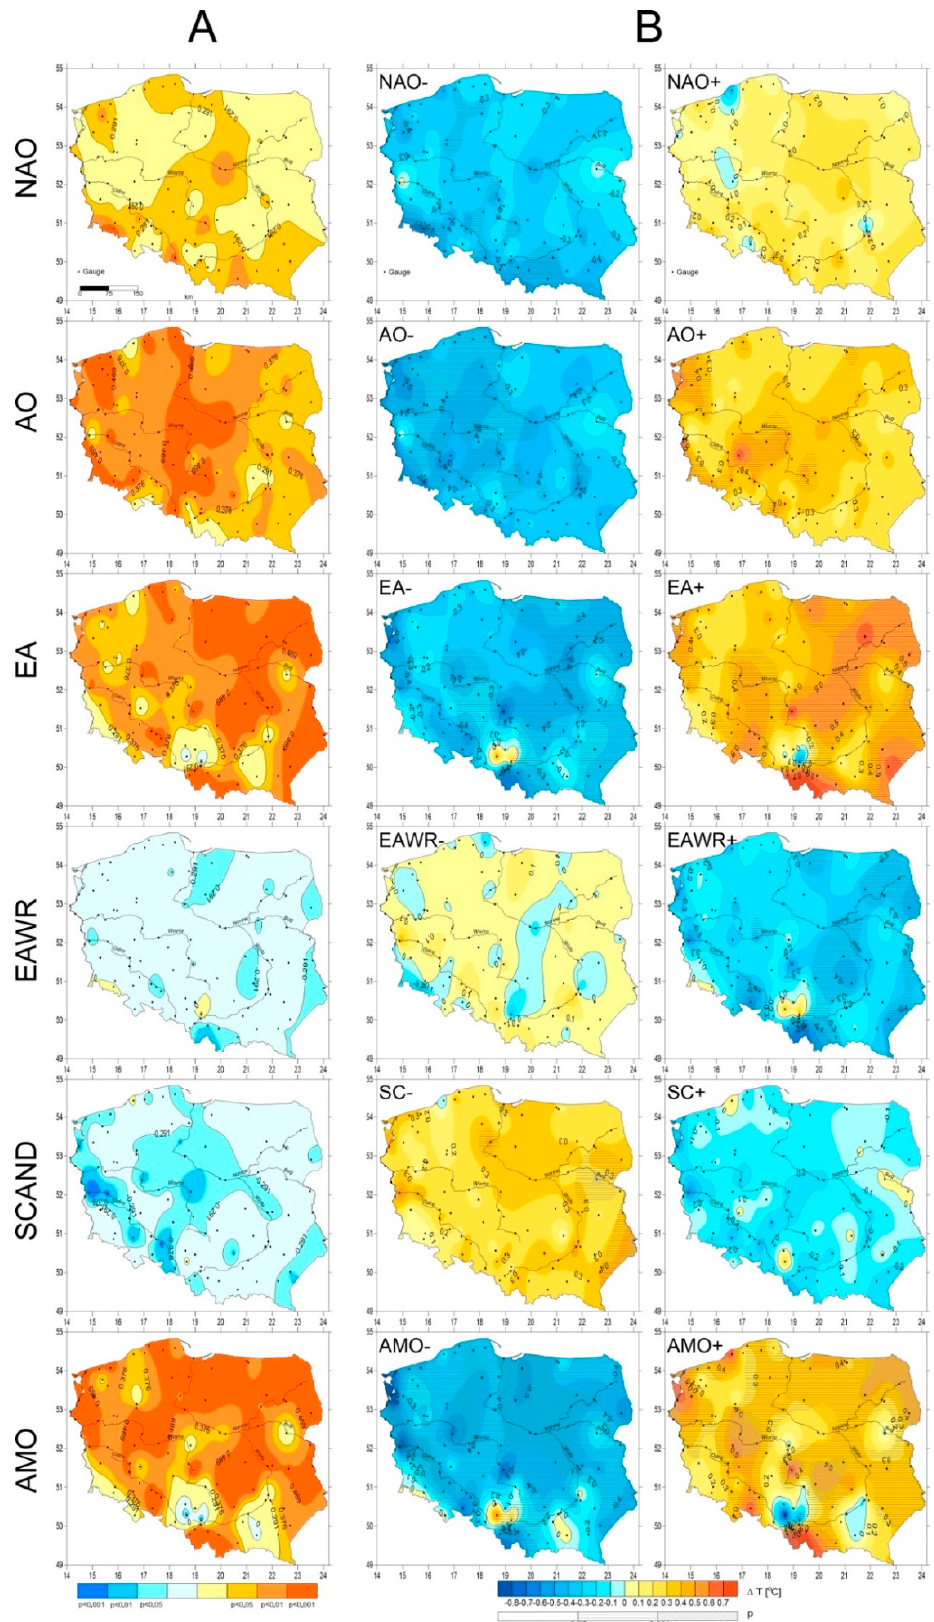
Figure 4. Spatial distribution of coefficients of correlation of annual water temperature values with indices of macroscale circulation types ( A ) and of deviations of annual temperature values ( ∆ T) in various phases thereof from average values for the years 1971–2015 and their statistical significance ( p )—( B ).